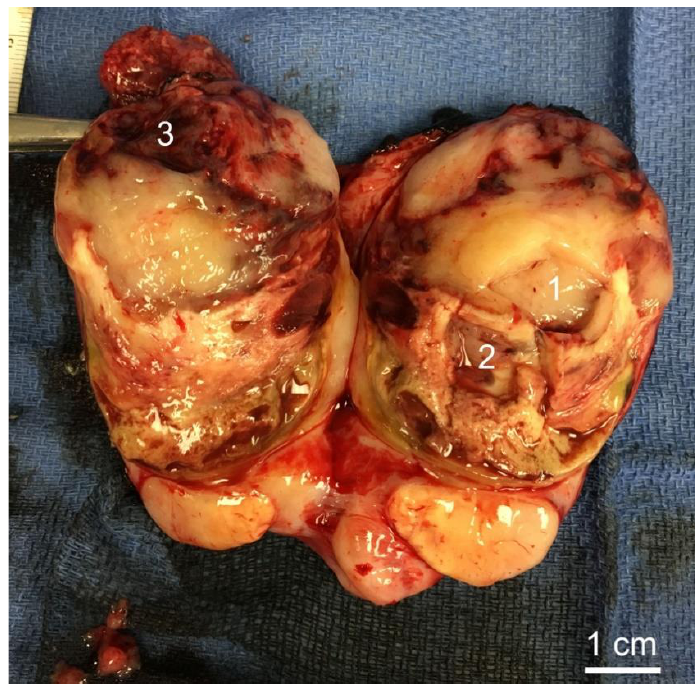
Figure 1. Malignant peripheral nerve sheath tumor (MPNST) sampled areas. Area 1 shows an area centrally located in MPNST, Area 2 an area of hemorrhage, and Area 3 an area of necrosis.